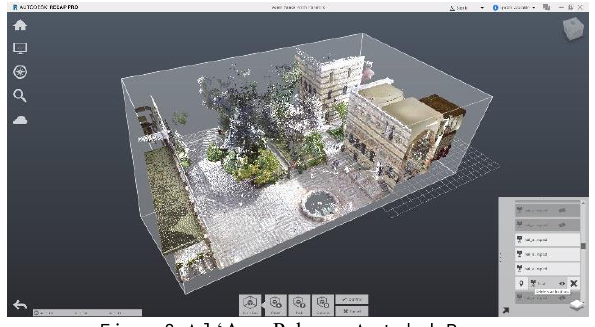
Figure 8. Al-‘Azm Palace – Autodesk Recap